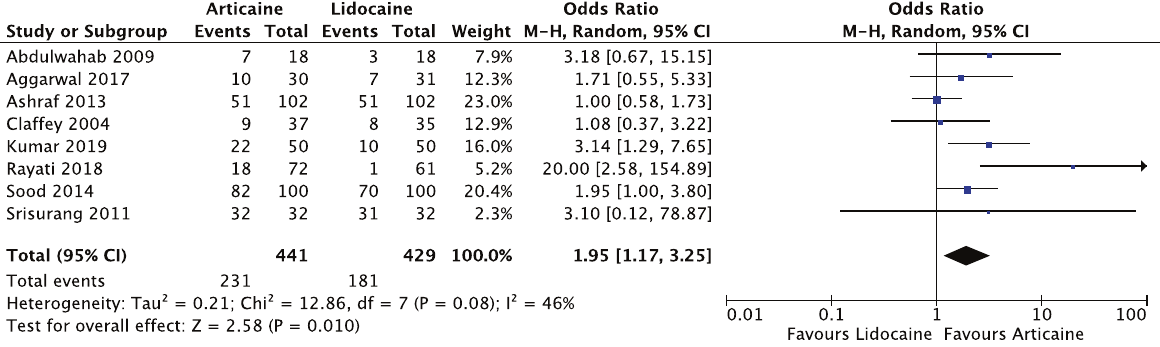
Fig. 13 Forest plot — all parallel randomised controlled trial studies. Articaine had 1.95 times likelihood of anaesthetic success of lidocaine.